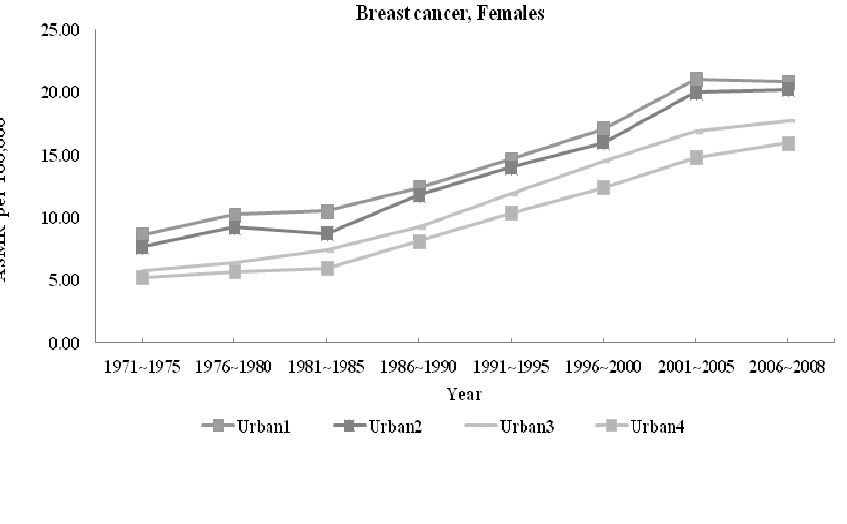
Figure 2. Avoidable Mortality by Urbanization Level, Gender-Specific